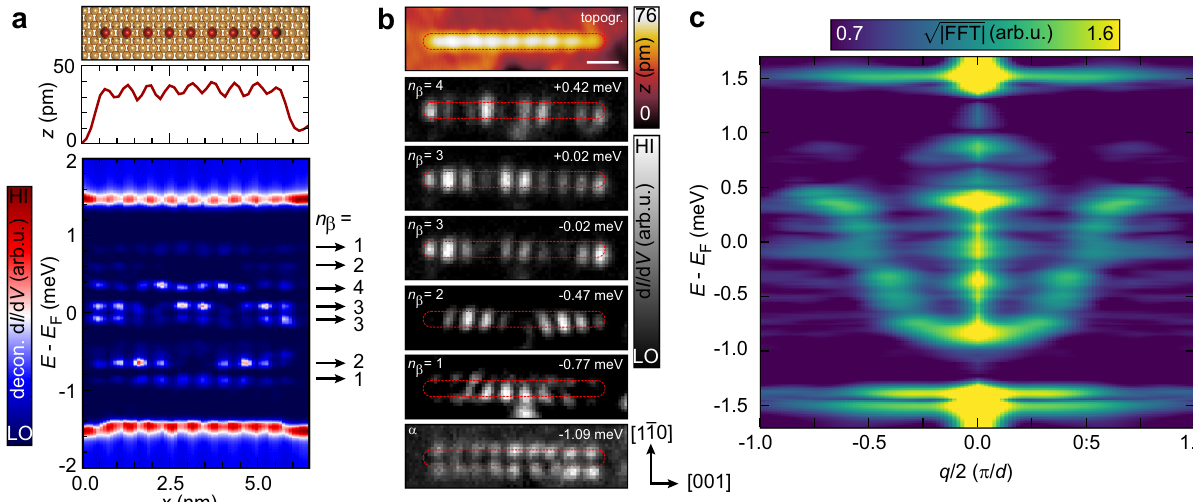
Figure 3 Measured dispersion of Bogoliubov-de Gennes (BdG) quasiparticles in Fe chains on Au monolayer. a Deconvoluted d I /d V line pro fi le (named decon. d I /d V , given in arbitrary units, arb. u.) and corresponding topographic line pro fi le ( z given in picometers, pm) measured along the longitudinal axis ( x ) of a Fe 9 2 a − [001] chain, as illustrated in the sketch at the top, where the red spheres depict the Fe atoms and the golden spheres the surface Au atoms. Black arrows mark the energies in the deconvoluted d I /d V line pro fi le at which n β maxima as indicated are observed along the chain. The subscript of this label refers to the orbital origin of this state ( V stab = 6 mV, I stab = 1 nA, V mod ¼ 20 μ V). b The colored topography image (topogr.) shows a scanning tunneling microscope (STM) image of a Fe 9 2 a − [001] chain and the grayscale images are d I /d V maps of this chain, obtained at energies indicated in the top right corner of each panel. The maps are labeled by n β in a similar fashion as the states in ( a ). The dashed red elliptical circumferences mark the spatial extent of the chain in the STM image. The white scale bar represents a length of 1 nm ( V stab = − 6 mV, I stab = 1 nA, V wise one-dimensional fast Fourier transforms (1D-FFT) obtained from d I /d V line pro fi les of Fe N 2 a − [001] chains with lengths N ranging from seven to fourteen atoms. Prior to the 1D-FFT, the spectra were deconvoluted. All d I /d V line pro fi les were obtained with the following parameters: V stab = 6 mV, I = 1 nA, V ¼ 20 μ stab mod